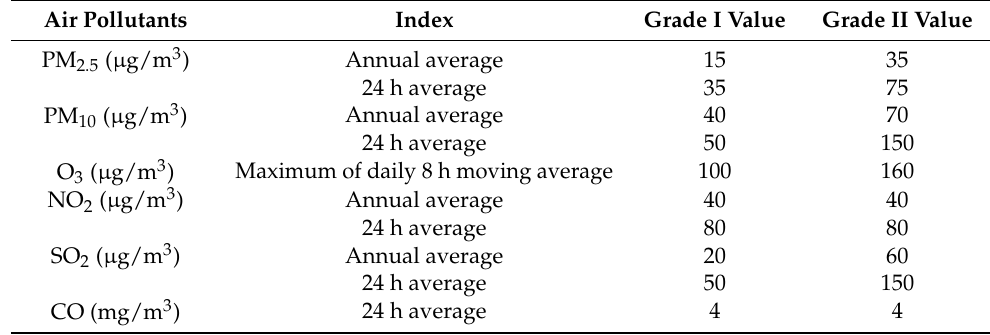
Table 1. Chinese ambient air quality